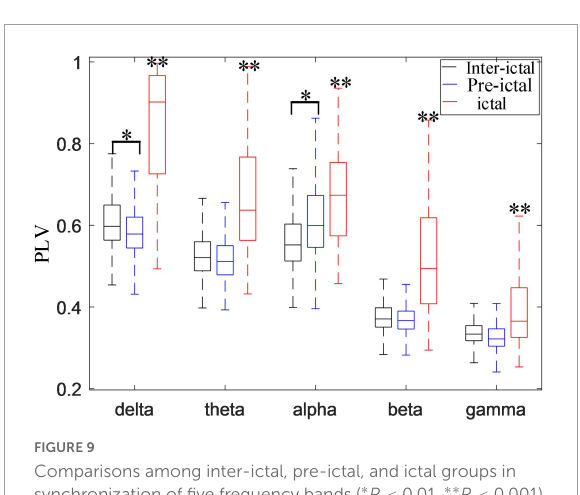
FIGURE9 Comparisons among inter-ictal, pre-ictal, and ictal groups in synchronization of five frequency bands ( ∗ P < 0.01, ∗∗ P < 0.001). The synchronization of all the rhythms in the ictal group was higher than inter-ictal and pre-ictal groups ( P < 0.001). Compared with the inter-ictal group, the synchronization of the delta band in the pre-ictal group was significantly decreased ( H delta = 18.569, P < 0.05), while the alpha band is enhanced ( H alpha = 29.517, P < 0.01) with the degrees of freedom m =